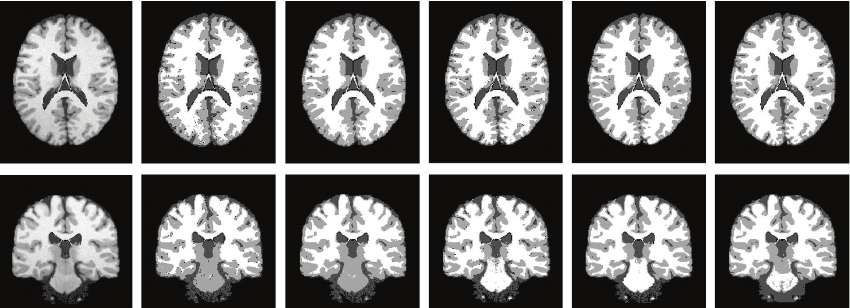
Figure 6: Comparison of segmentation results on two simulated brain MR images. Column 1: original images. Column 2: the BCFCM